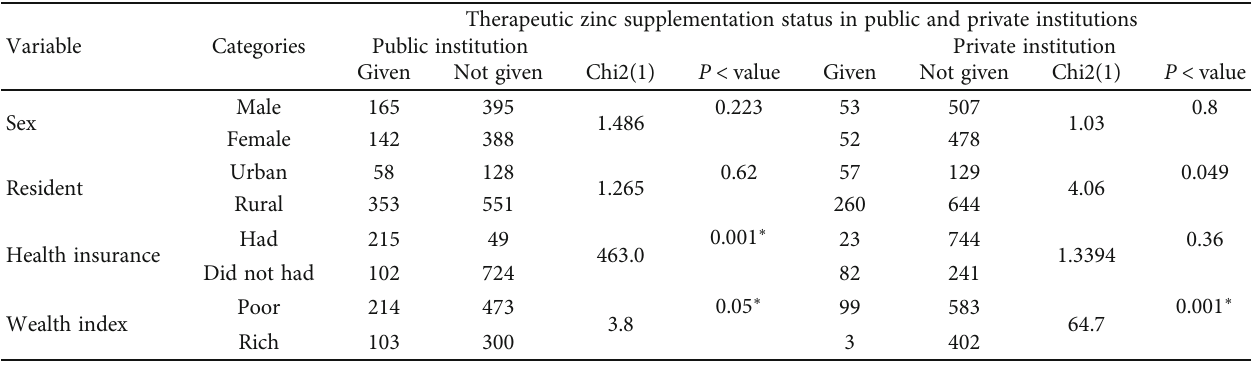
Table 2: Levels of zinc supplementation in public and private health institutions for diminutions of acute diarrhea cases on selected sociodemographic variables.